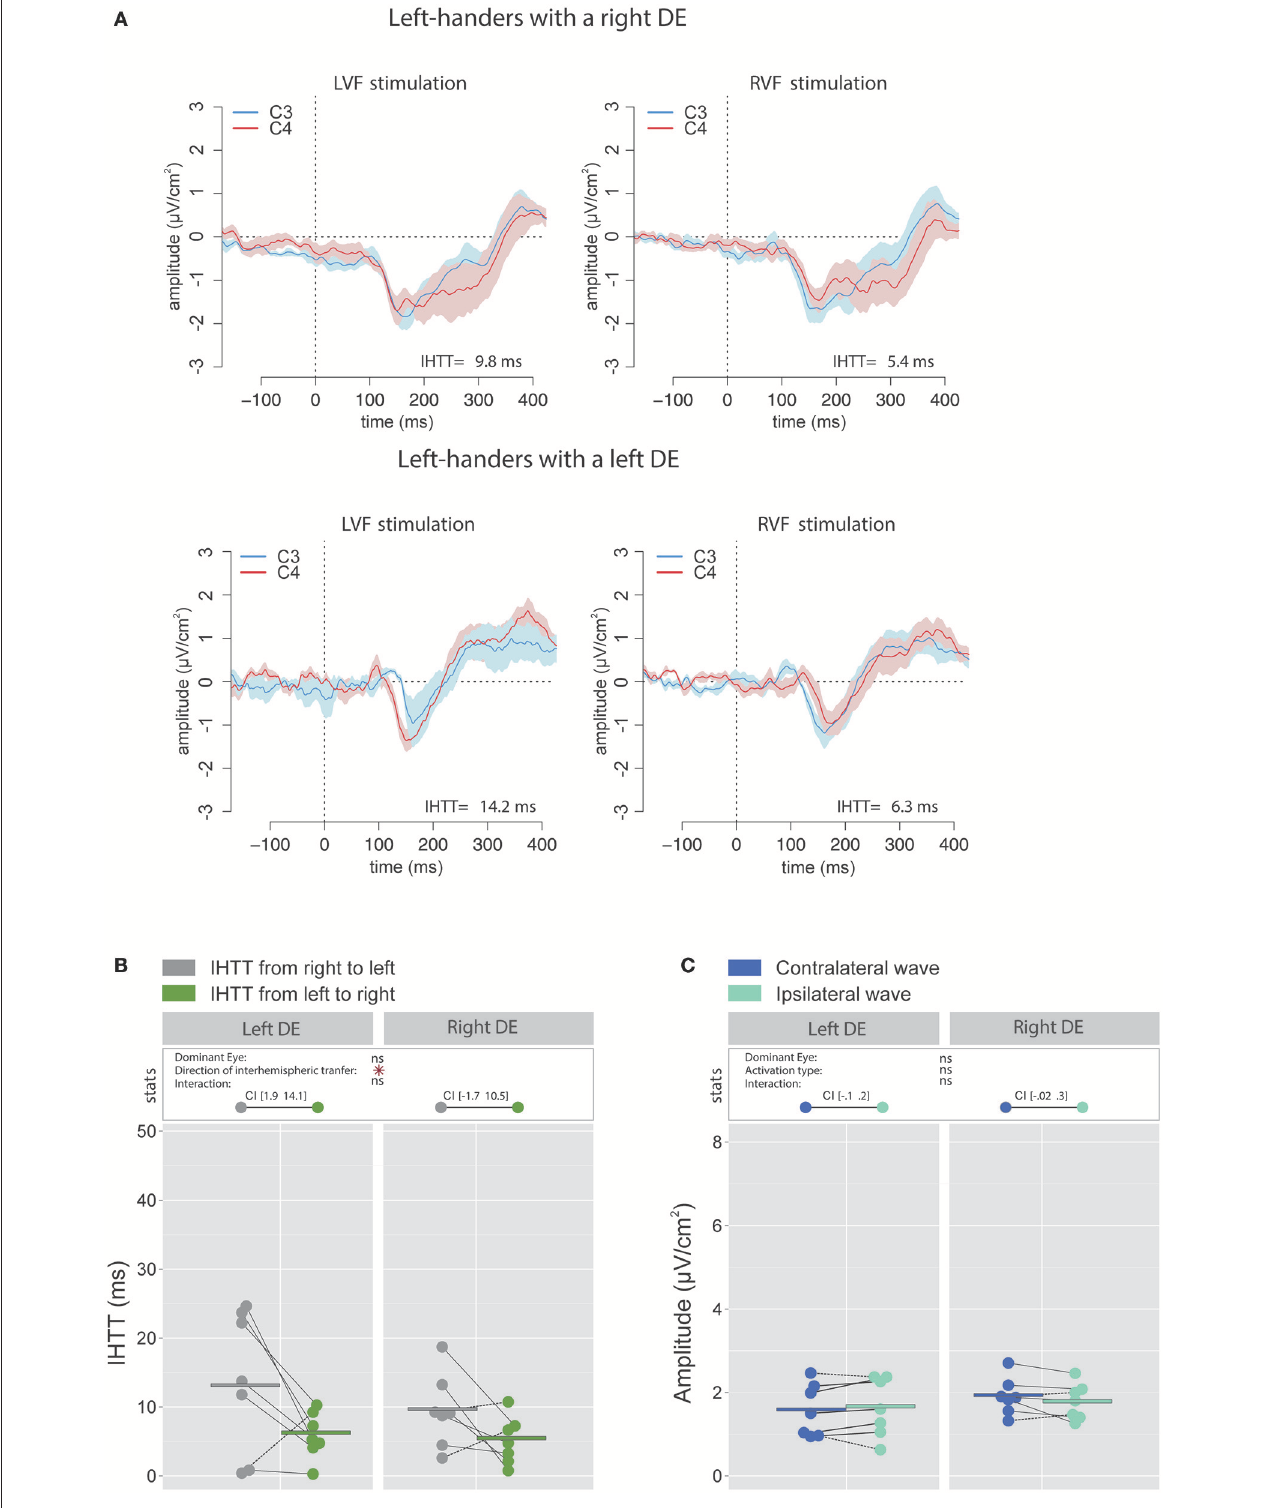
FIGURE 7 | Waveforms and average results computed over central sites after Laplacian transformation in left-handers. (A) Grand average CSD waveforms recorded over C3 (blue waves) and C4 (red waves) electrodes in the two experimental conditions (LVF or RVF stimulation). Shading blue and red areas represent the